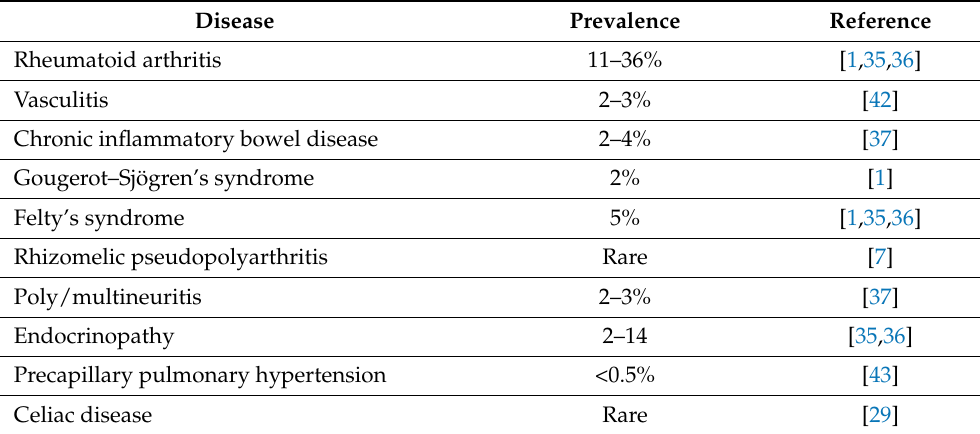
Table 2. Autoimmune conditions associated with LGL